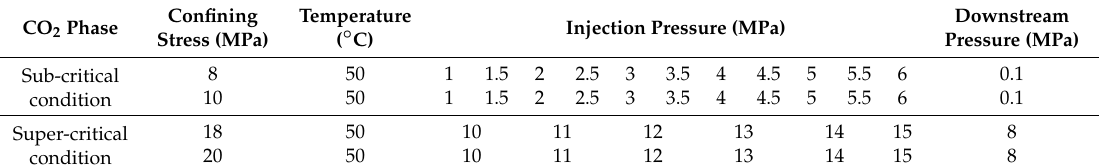
Table 3. Procedure of sub-critical and super-critical CO 2 permeability test.